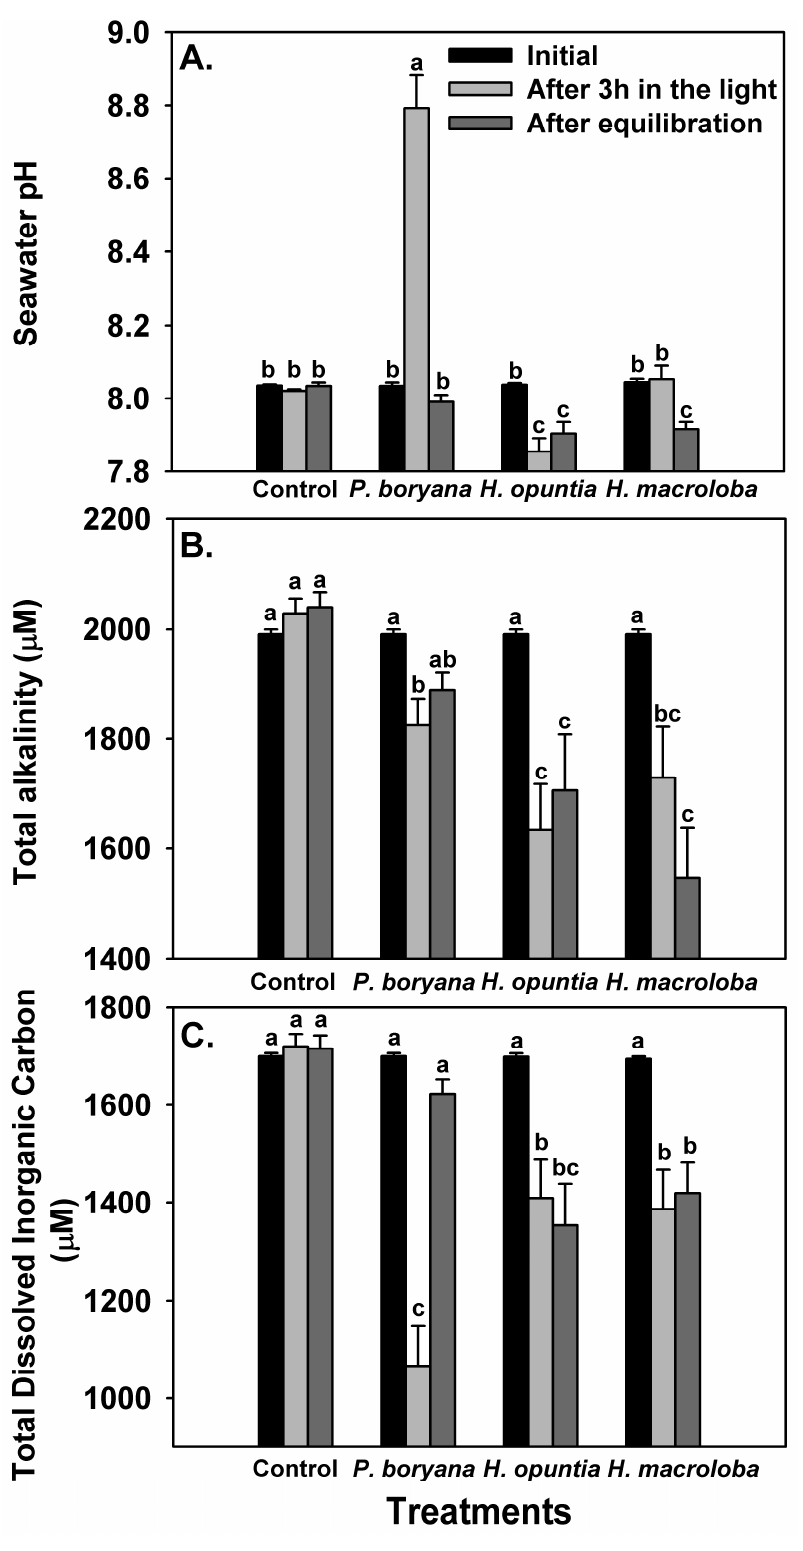
Figure 2. Changes in seawater chemistry: pH ( A ), total alkalinity ( B ) and total dissolved inorganic carbon ( C ) after incubation with Padina boryana , Halimeda opuntia and Halimeda macroloba under an irradiance of 150 µ mol photons m − 2 s − 1 and after equilibration with air. The same set-up without macroalgae serves as the control. Bars without shared letters are considered statistically different (Fisher’s LSD test, p < 0.05). Data are means ± SE (n =